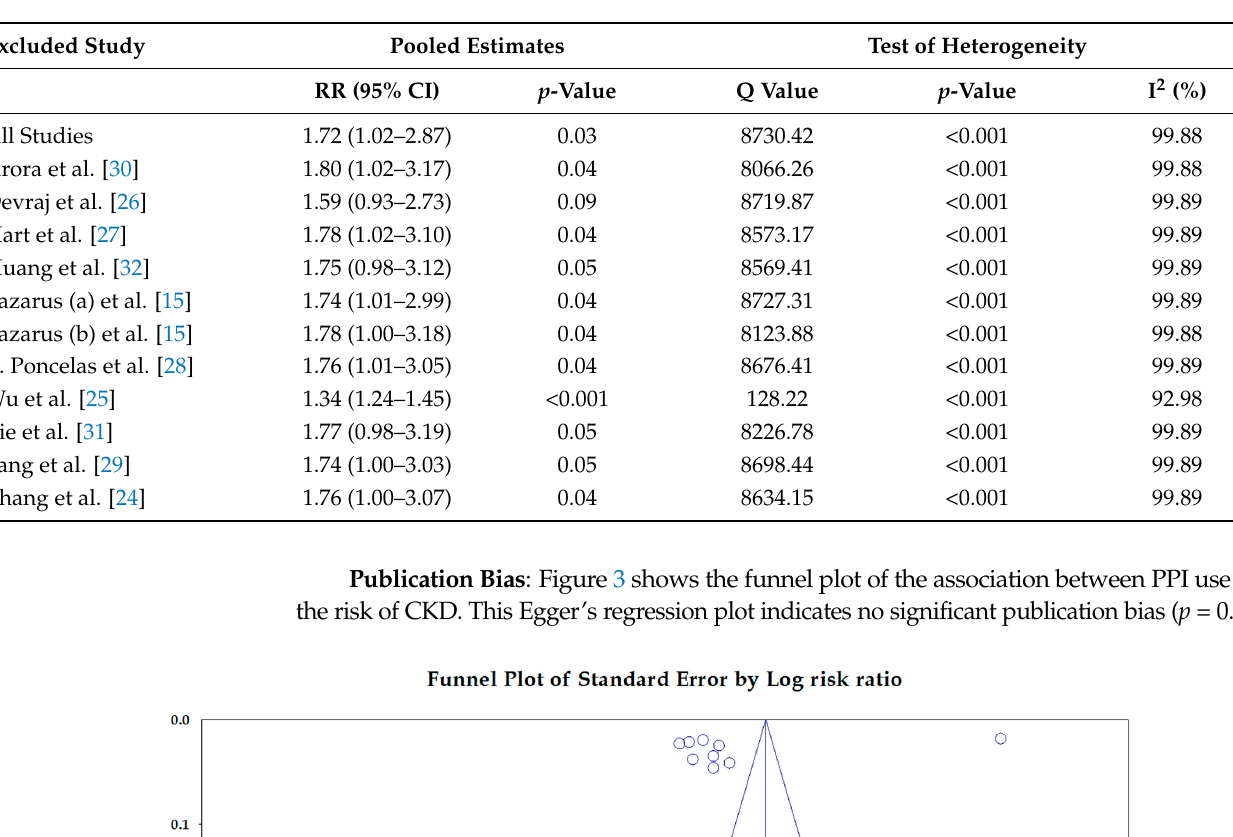
Table 3. Sensitivity analysis for the association between PPI and CKD risk.